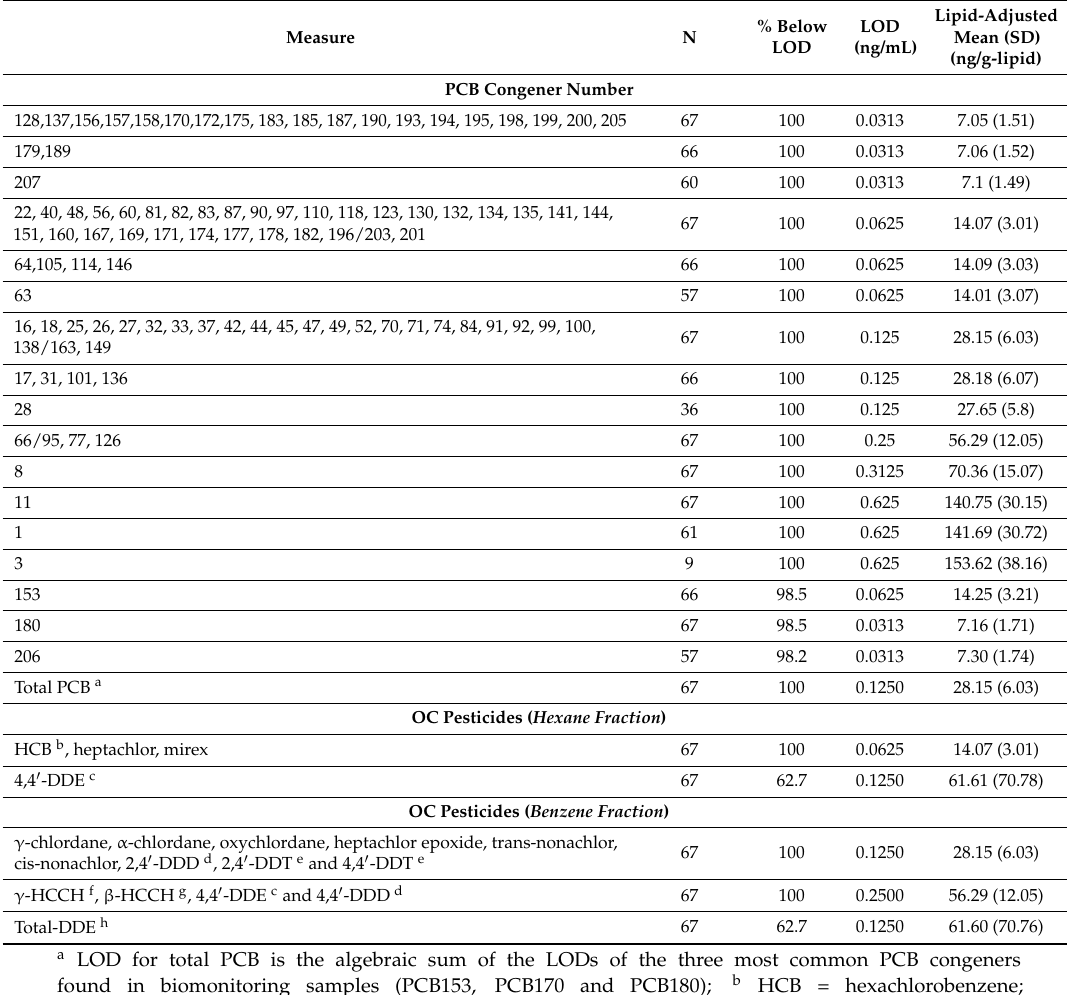
Table 2. Lipid adjusted mean concentrations of PCBs and OC pesticides in cord blood serum samples of 67 Jamaican newborns from the JA Kids